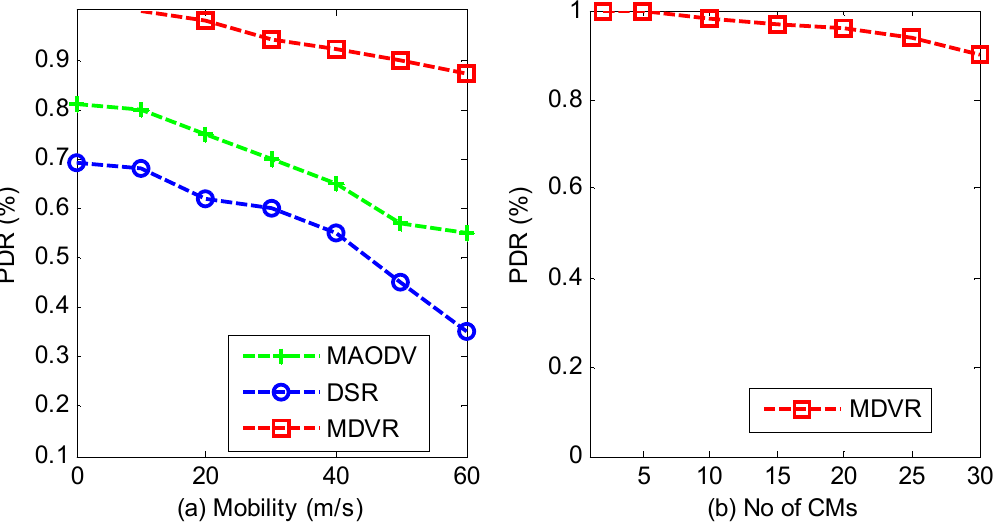
Figure 6. ( a ) UGAVs-MDVR PDR concerning mobility; ( b ) UGAVs-MDVR PDR for the number of CMs .